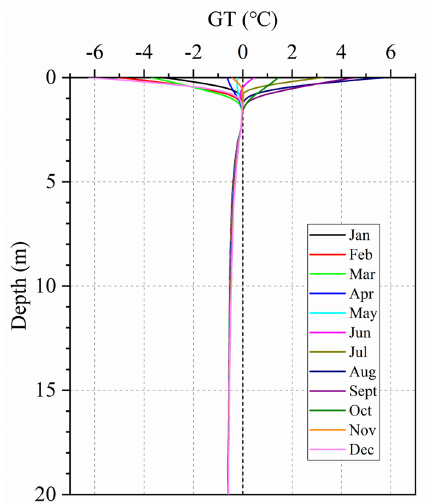
Figure 5. Monthly average ground temperatures (GTs) at depths of 0-20 m recorded in the JB-B-II borehole at the JB site in 2018.